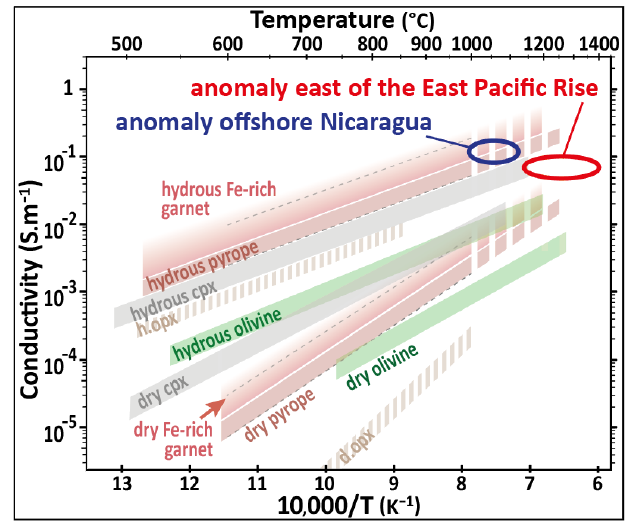
Figure 5. Conductivity of major mantle minerals and impact of hydration. Electrical conductivity versus reciprocal temperature for olivine, clinopyroxenes and garnets. The green, gray, red and hatched brown shades correspond to electrical conductivity values for dry olivine (X Fe = 0.1) [50], hydrous olivine (465 ppm H 2 O) [51], dry and hydrous (375 ppm H 2 O) clinopyroxene [52], dry and hydrous (465 ppm H 2 O) pyrope (Py 73 -Alm 14 -Grs 13 , 2 GPa) [28] and dry and hydrous (200 ppm H 2 O) orthopyroxene [40].